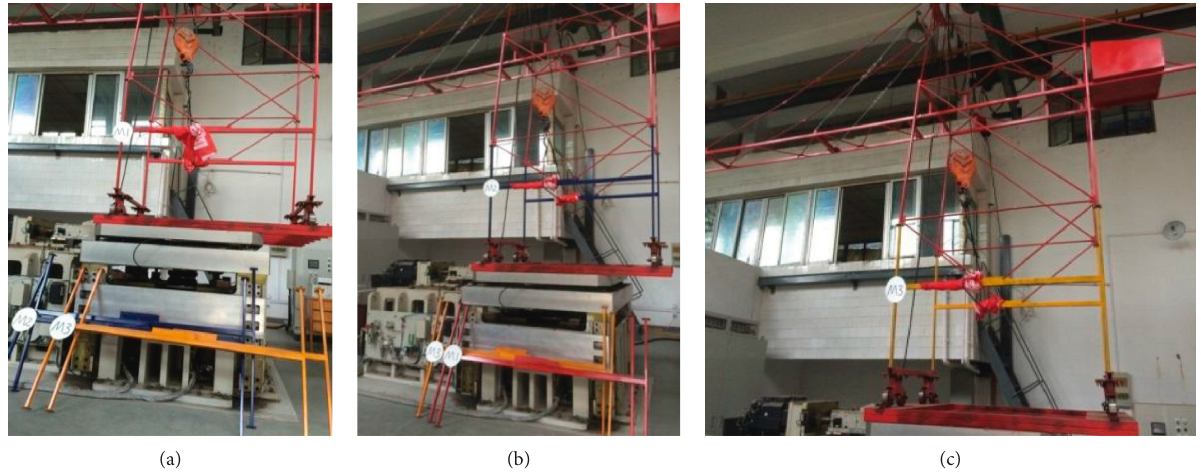
Figure 7: Test models. (a) M1. (b) M2. (c)